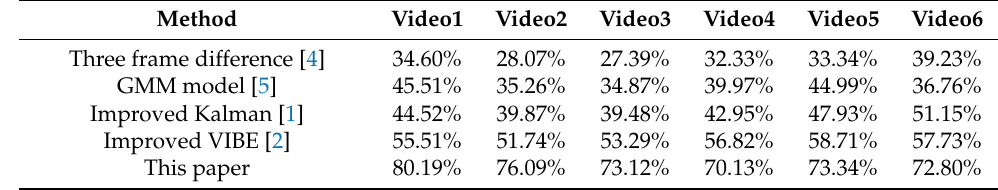
Table 8. The comparison between our method and traditional video object detection methods.